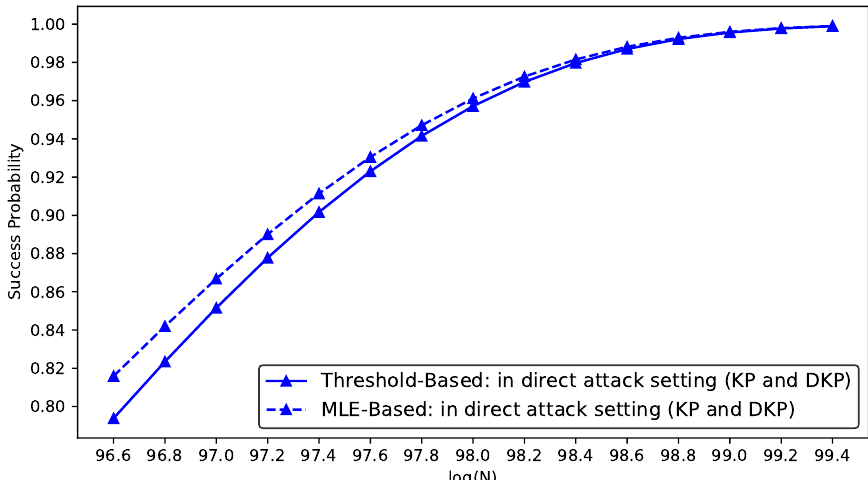
Figure 13: Comparison between the MLE-based model and the threshold-based model of the success probabilities of direct attacks on